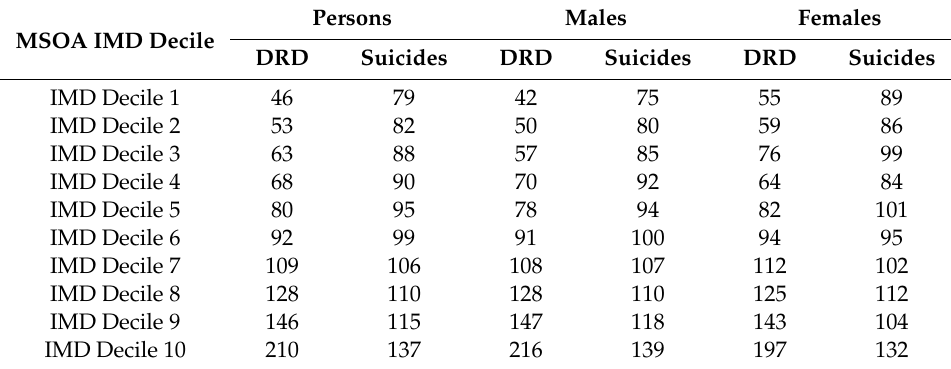
Table 1. Drug-related deaths (DRD) and suicides, standard mortality ratios by Middle Level Super Output Area (MSOA) deprivation